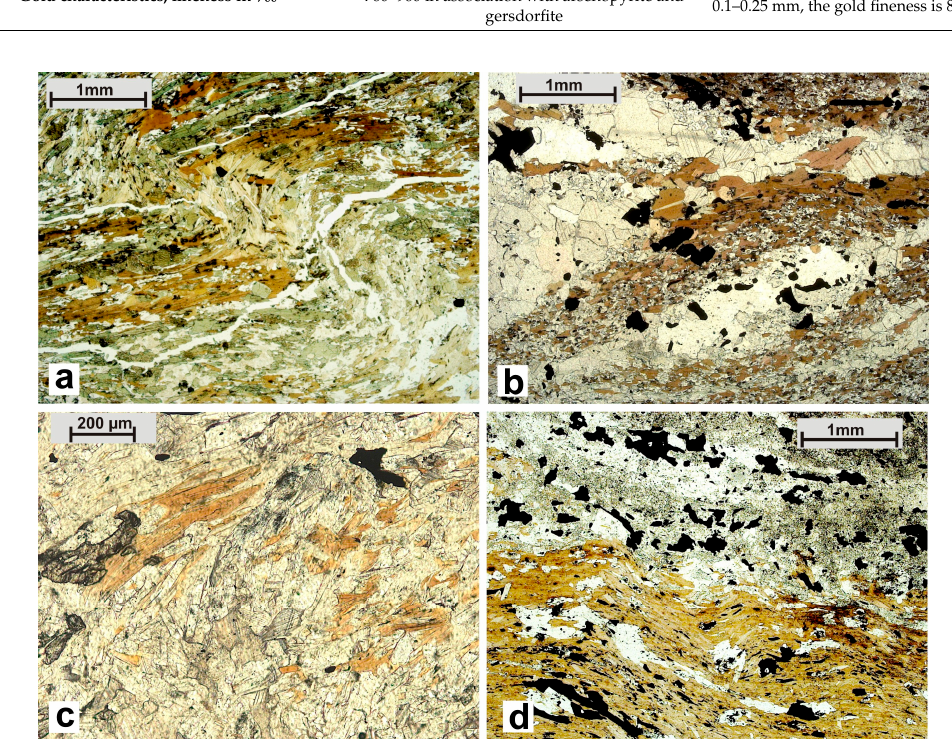
Figure 9. Altered rocks from the Sergozerskoe gold occurrence, thin sections photos, transparent light, one polarizer. ( a ) Biotitizated folded hornblende amphibolite, ( b – d ) calcite–biotite metasomatite: ( b ) after hornblende amphibolite, ( c ) after actinolite-chlorite amphibolite, ( d ) after diorite porphyry.